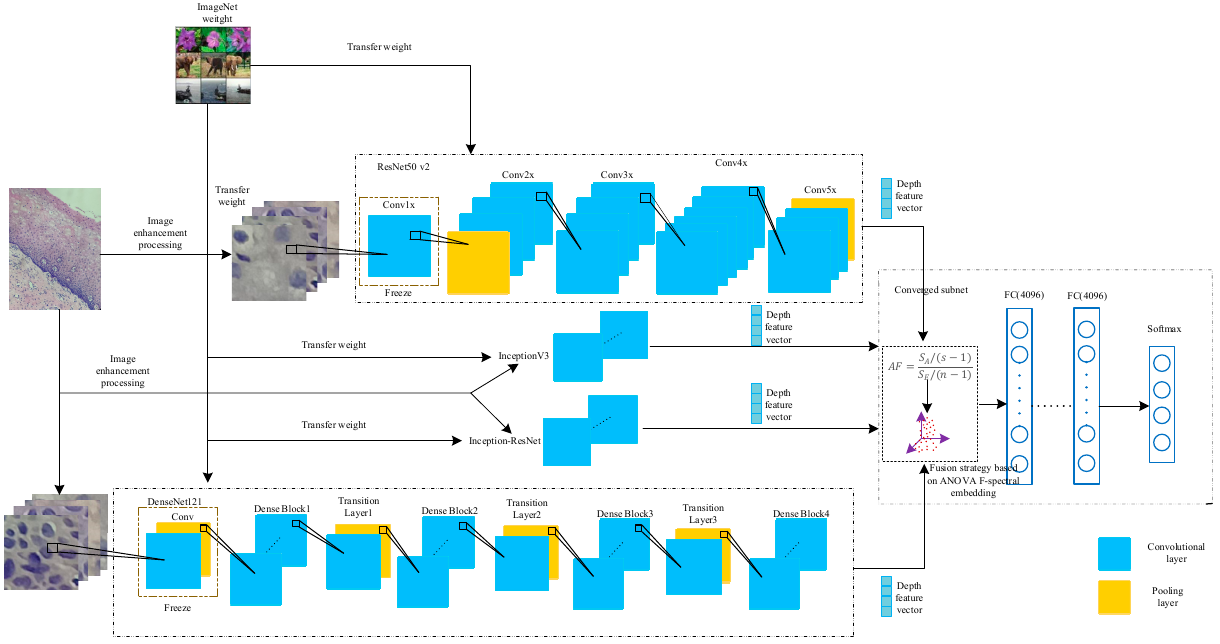
Figure 6. The framework of the proposed method of pathological cervical image classification is based on fusion deep network convolutional features. Table 3. Core parameters of each layer of the Analysis of Variance-F value-Spectral Embedding Net (AF-SENet model).